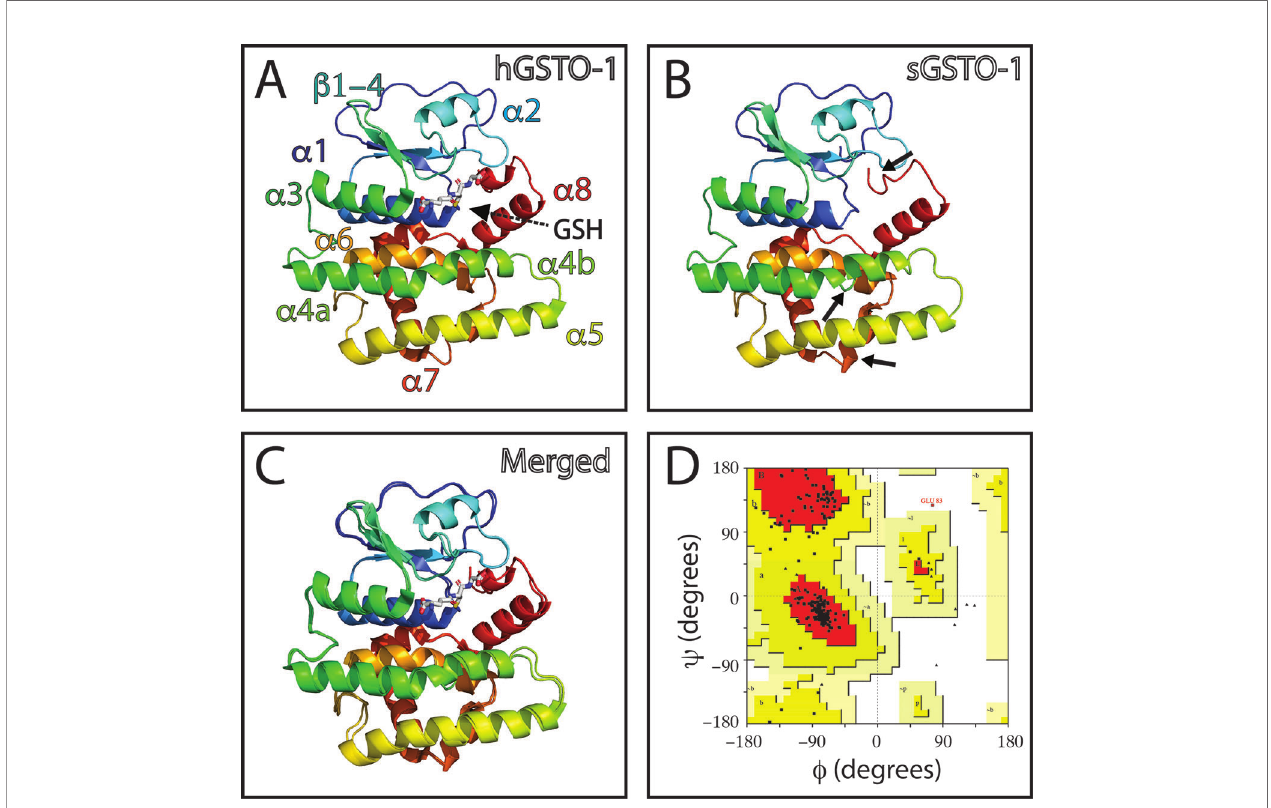
FIGURE 1 | Homology modeling for predicted S. salar GSTO-1 based on H. sapiens GSTO-1 structure. (A) Tridimensional H. sapiens GSTO-1 (hGSTO-1) structure. (B) Predicted tridimensional S. salar GSTO-1 (sGSTO-1) structure. The differences on the secondary structure in the sGSTO-1 compared to hGSTO-1 are shown (arrow lines). (C) hGSTO-1 and sGSTO-1 overlay. (D) Ramachandran plot for the predicted sGSTO-1 structure. The amino acid distribution into most favored regions (A,B,L), additional allowed regions (a,b,l,p), generously allowed regions (~a,~b,~l,~p), and disallowed regions (GLU83) is indicated. In the protein structures, a -helices ( a 1- a 8), b -sheets ( b 1-4) are indicated. The reduced glutathione (GSH) molecule is